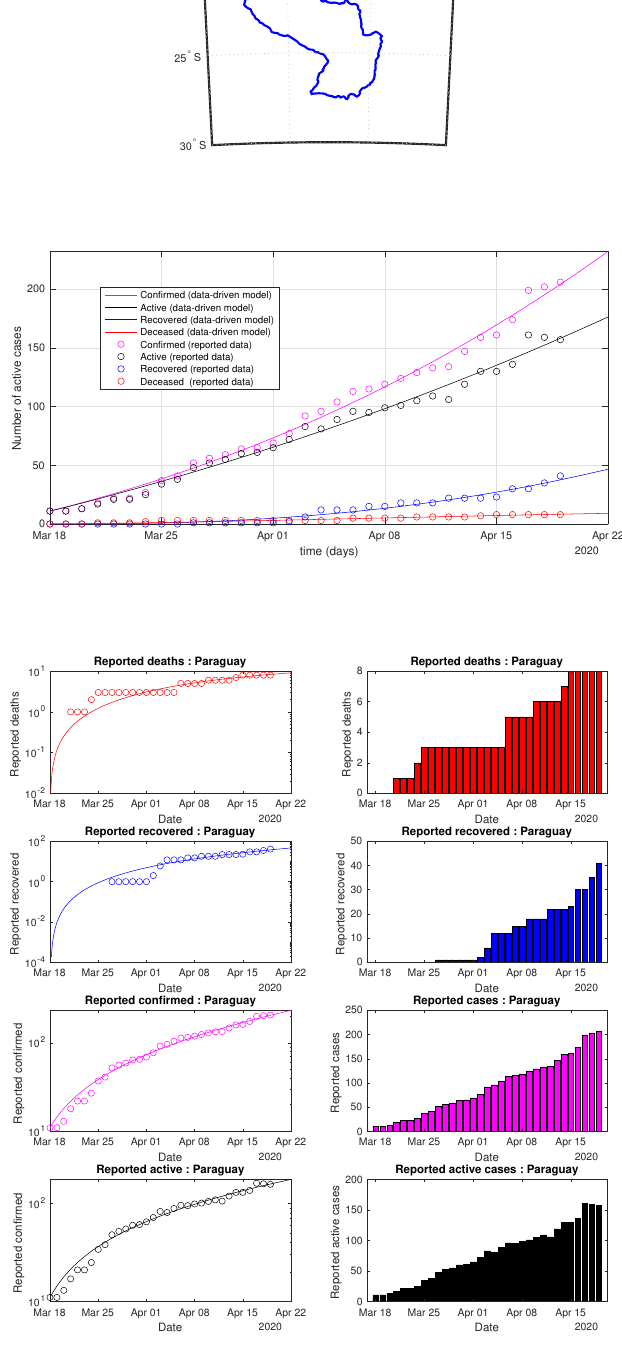
Figure 26. Paraguay: data of active, recovered, deceased (in circle or bar) vs. model of active, recovered, deceased over time. Tracking the number of active cases. Predictive analytics for the next couple